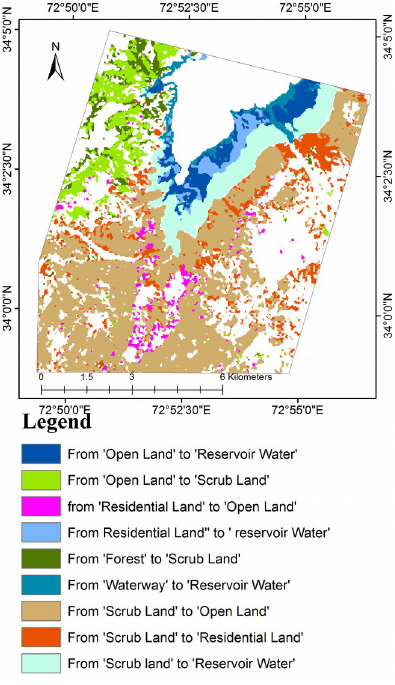
Figure 5. S pring to summer seasonal change detection 3.7 Seasonal Change Detection from Spring to Autumn Change detection matrix (Table 6) from spring to autumn shows decrease of spatial distribution of forest 55.6%, waterway 24.3%, scrub land 65.6% and increase of open land 223%, reservoir water 23.9% and residential land 15.8%. Figure 6 shows category changes with increases in dam water mapping from waterway to reservoir water, open land to reservoir water, residential land to reservoir land, scrub land to reservoir land resulted increase of reservoir water. Similarly change of category from scrub land to open land and forest to open land resulted increase of open land. Small category changes from open land to scrub land and forest to scrub land resulted due to seasonal change. Seasonal change detection from spring to autumn resulted increase of reservoir water and open land.